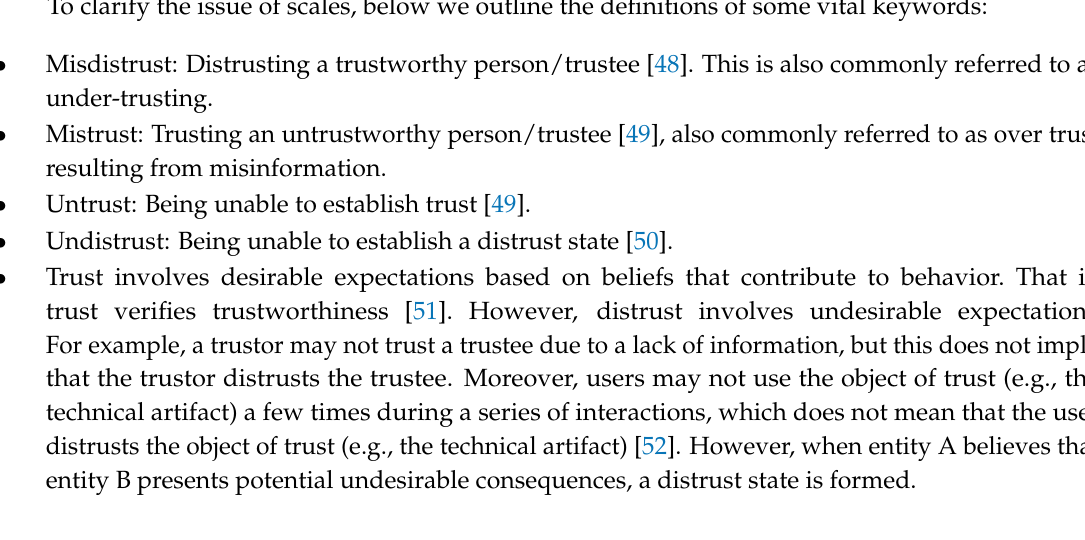
Figure 10. Classification of trust scales used in studies assessing trust with psychophysiological